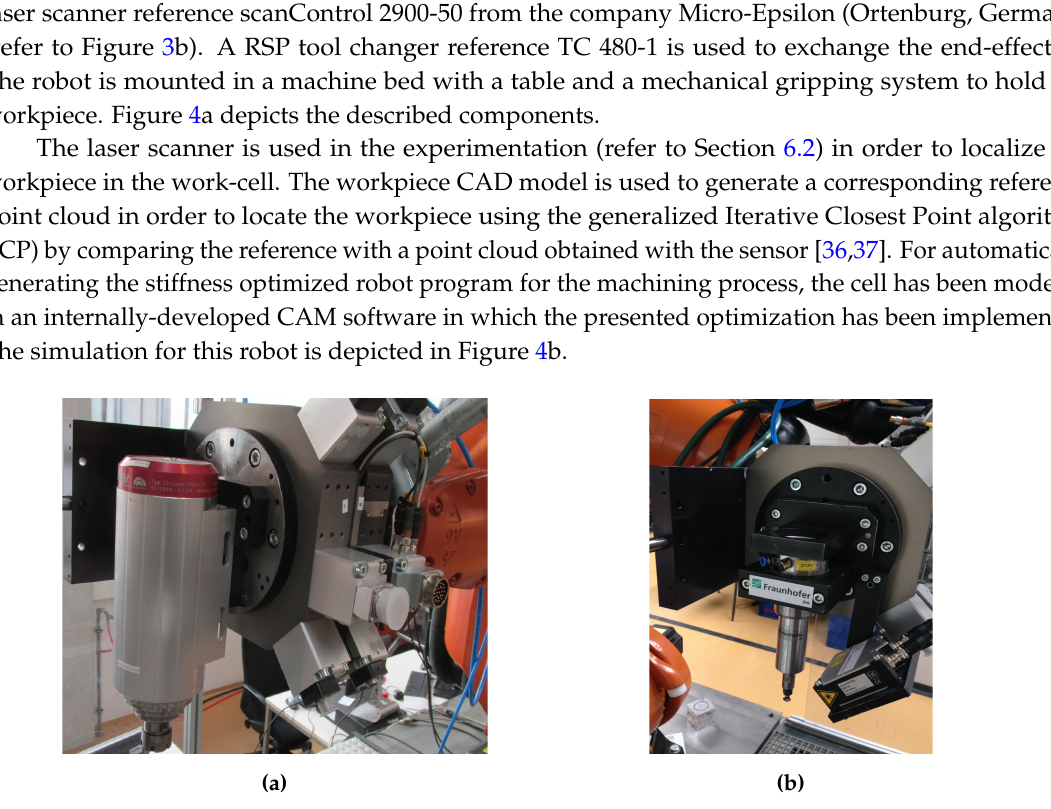
Figure 3. ( a ) Robot end-effector with the milling tool; ( b ) robot end-effector with the sensor.